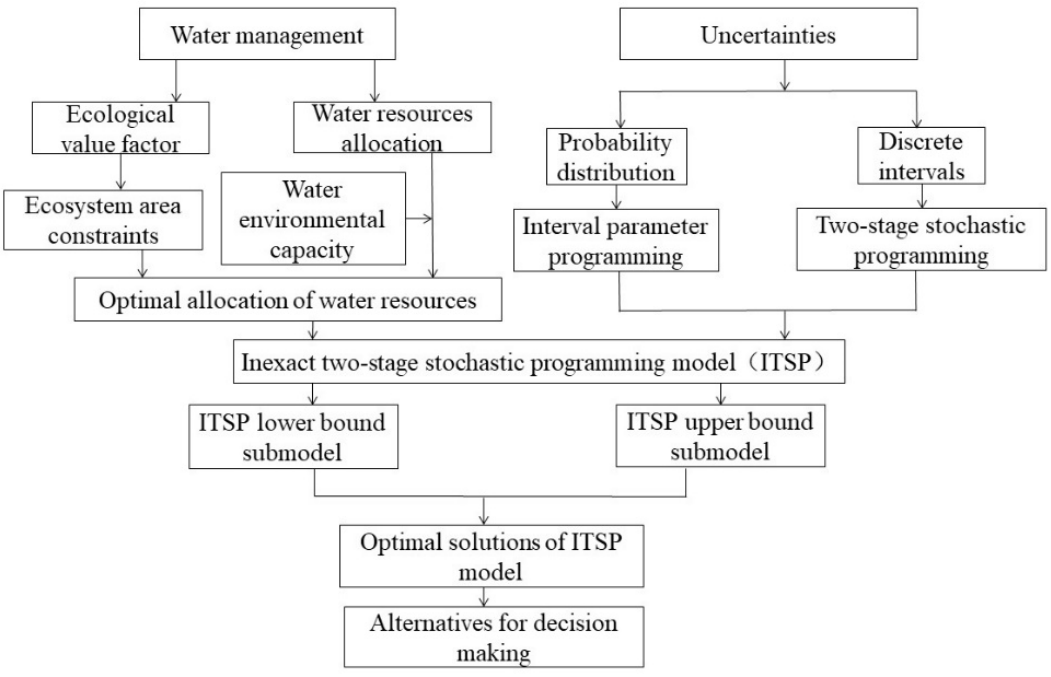
Figure 1. Framework for the inexact two-stage stochastic programming (ITSP) model.